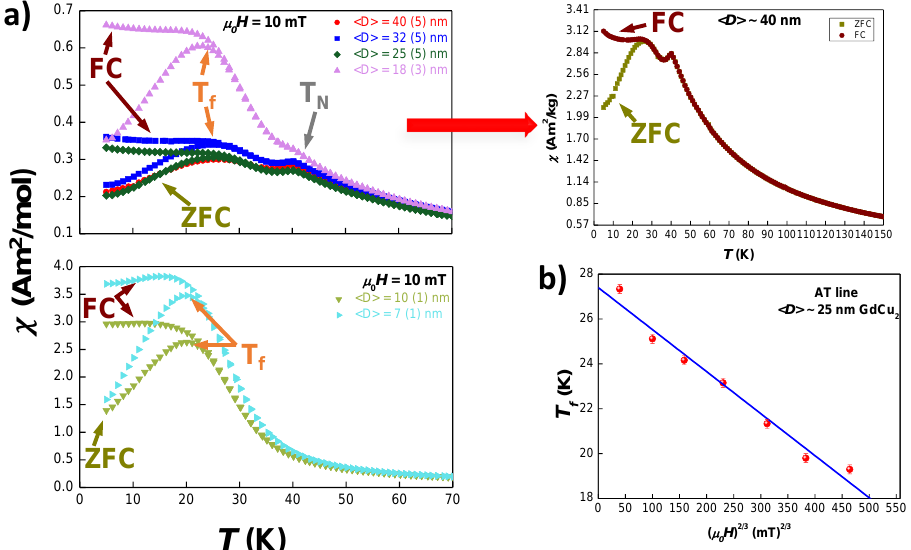
Figure 3. ( a ) ZFC (marked with dark yellow arrows) and FC (brown arrows) curves of DC-susceptibility of the milled samples, at µ 0 H = 10 mT. Top: GdCu 2 NPs where T N and T f coexist (i.e., (cid:104) D (cid:105) ≥ 18 nm). Measurements for the data corresponding to the larger NPs ( (cid:104) D (cid:105) = 40(5) nm) are represented individually at the right side, where different colours have been employed to distinguish between the ZFC branch (dark yellow) and the FC one (brown). Bottom: GdCu 2 NPs where the T N transition is suppressed ( (cid:104) D (cid:105) ≤ 10 nm). Both plots reveal an increasing χ DC when reducing the NP size. ( b ) Variation of the freezing temperature T f versus H 2/3 for (cid:104) D (cid:105) ≈ 25 nm GdCu 2